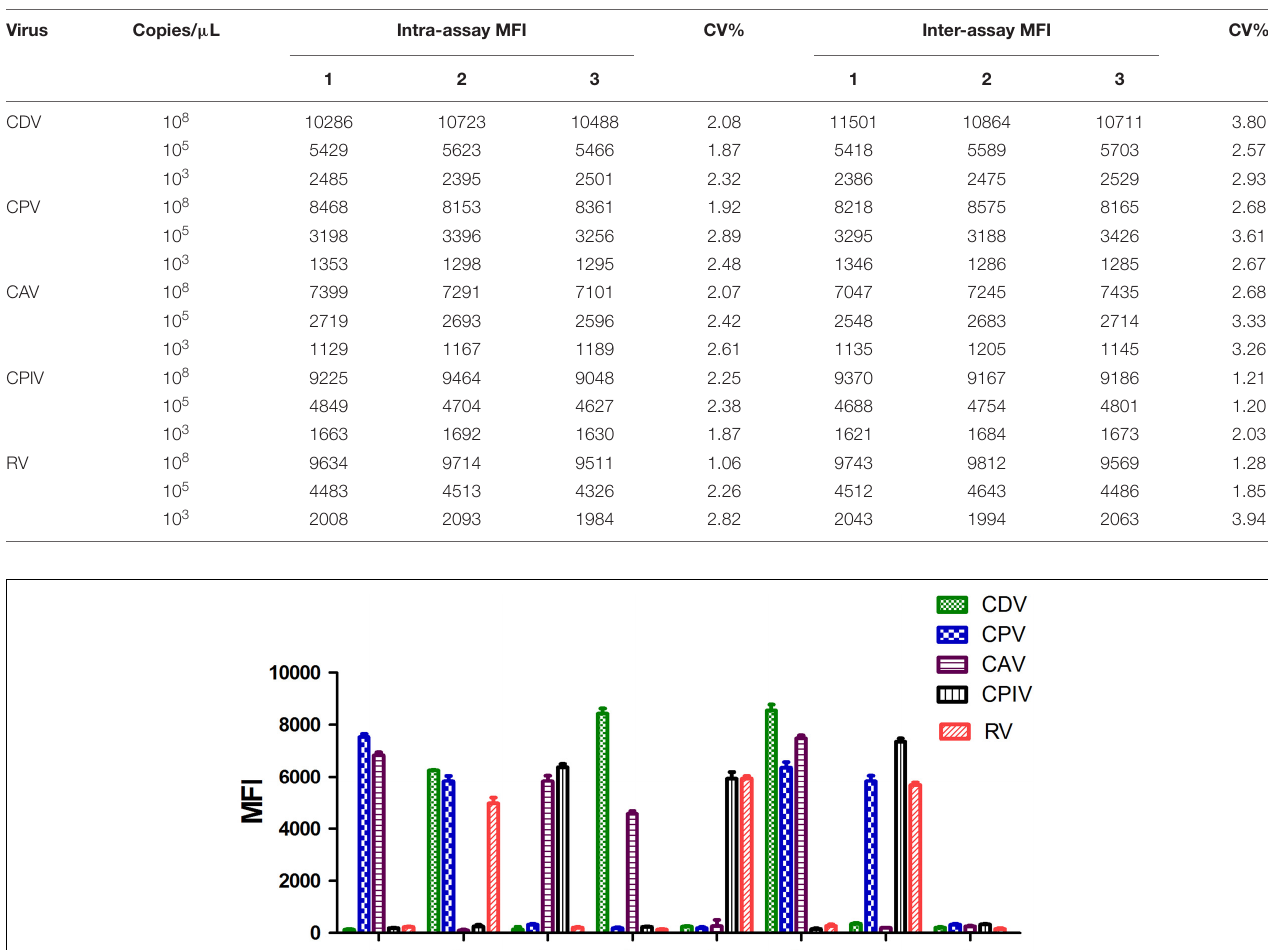
TABLE 4 | Reproducibility and stability analysis of the Luminex xTAG assay.